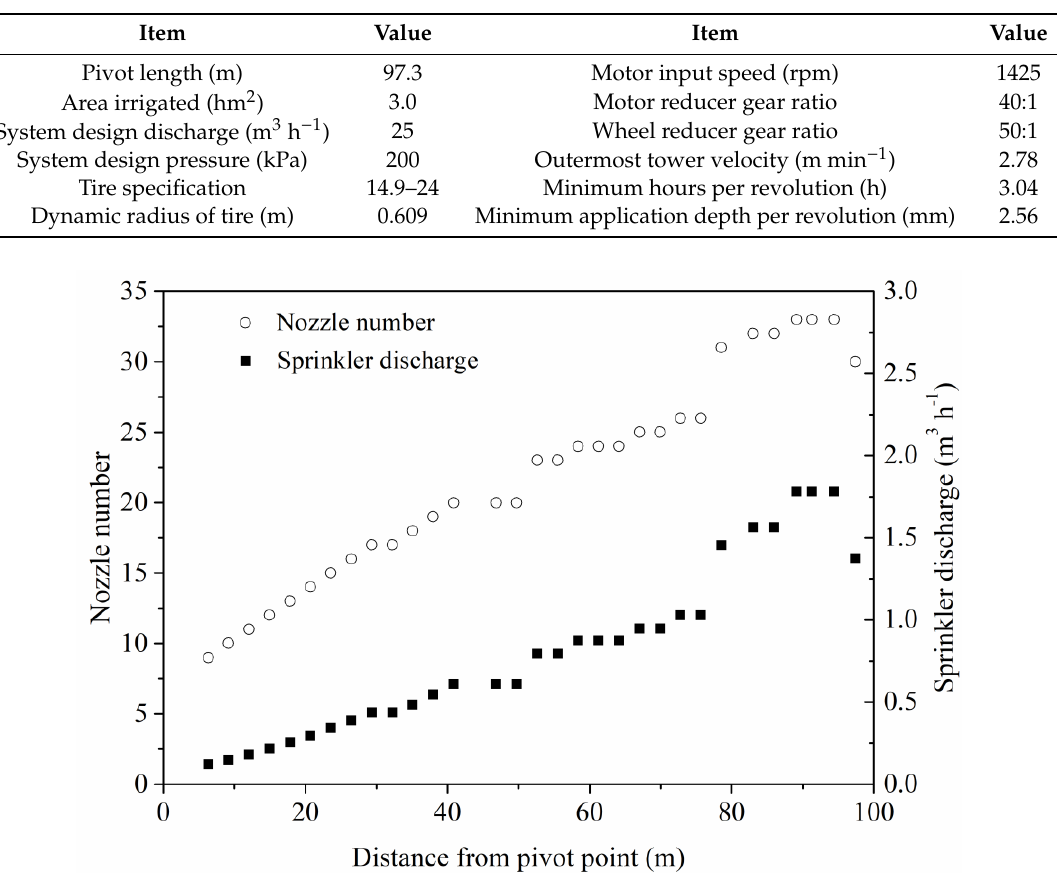
Figure 2. Nozzle number and sprinkler discharge along the lateral pipe of the center pivot irrigation system.